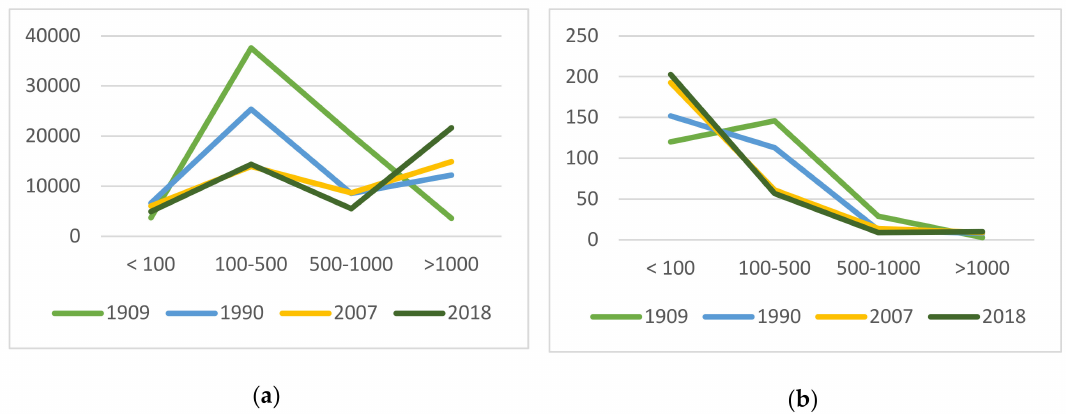
Figure 7. Structural changes in the rural settlement system of the Mogilev district (in absolute units): ( a ) population; ( b ) rural settlement amount.